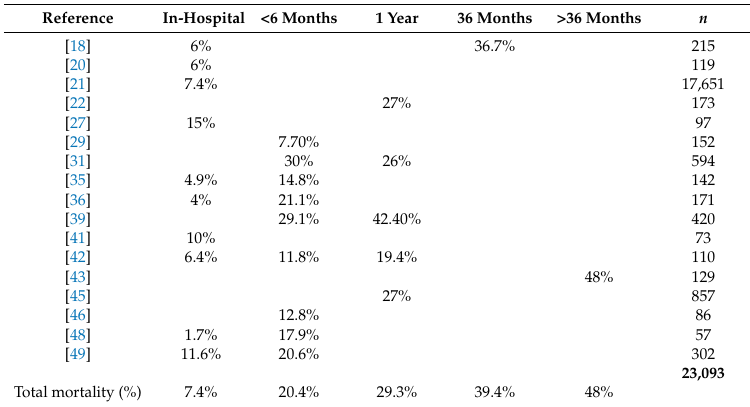
Table 5. Total mortality during hospital stay, and at various stages after